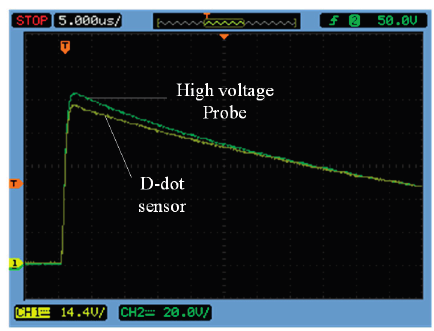
Figure 12. Measure waveform in 1.2/50 μ s lightning